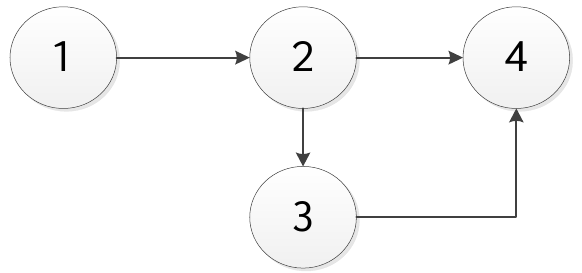
Figure 9. Failure chain model of the power transmission device.